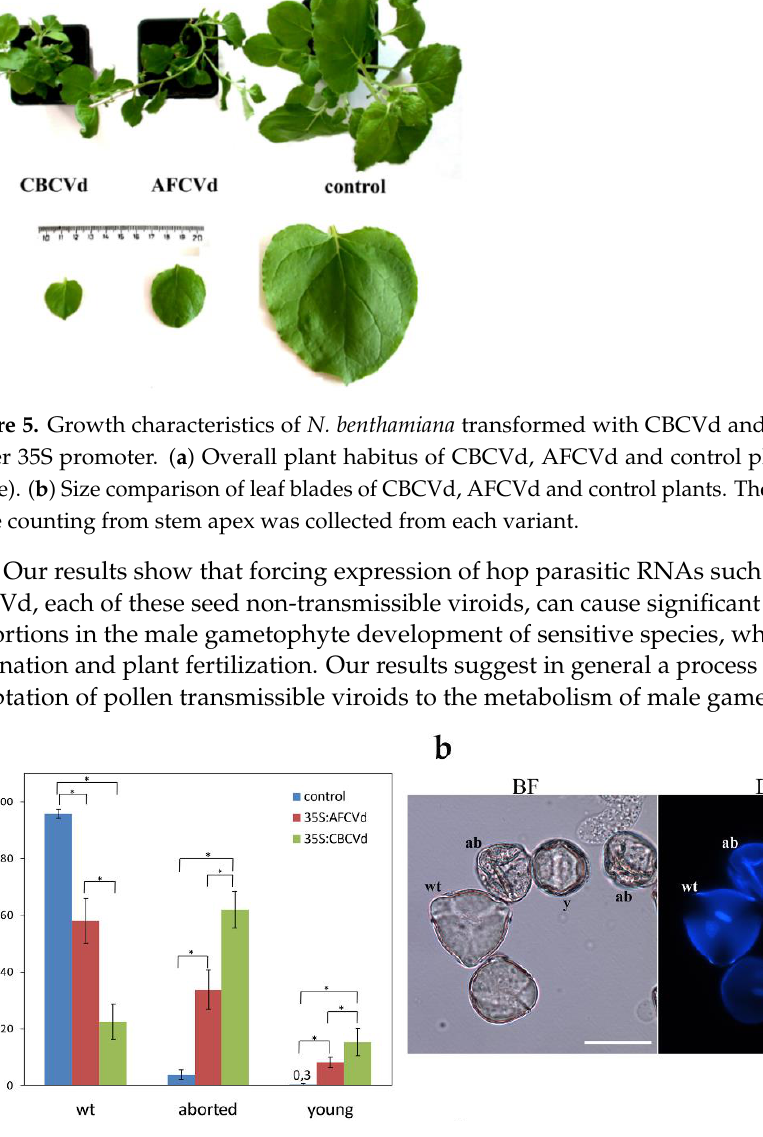
Figure 6. Microscopic analysis of mature pollen of control, 35S:AFCVd and 35S:CBCVd trans- formed N. benthamiana . ( a ) Quantification of the most common pollen phenotypes (in percent, mean ± S.D., n ≥ 9); healthy looking mature pollen grains (wt), aborted pollen (aborted) and young im- mature pollen grains (young). Lines with asterisks (* p < 0.05) indicate statistically significant dif- ferences between connected values. ( b ) Microscopic images of wt, aborted (ab) and young (y) pol- len grains quantified in graph. ( c ) Overall microscopic views of mature pollen of the relevant var- iant. ( d ) Microscopic images of trinuclear pollen grain (asterisk), pollen with malformed nucleus (m) and pollen with partially degraded nucleus (dn) found in mature pollen of 35S:CBCVd trans- formed plants. (BF) bright field, (DAPI) fluorescence after DAPI staining and scale 30 µm in all microscopic images. For plant transformation, the same plant vectors with dimeric AFCVd and CBCVd cDNAs under 35S promoter were used (Figure S5a,b [7]). N. benthamiana transformation was performed using the standard leaf disc method [40]. Regenerated transformed plants, designed as 35S:AFCVd and 35S:CBCVd, were maintained in a medium contain- ing 100 mg/L kanamycin and 200 mg/L Timentin. CBCVd infected hop pollen was collected in the middle of July 2017 from naturally infected male hop genotype 19058 grown in the experimental field of Slovenian Institute of Hop Research and Brewing. For AFCVd infection, male genotype from the crossing of female no. 211/96 x male no. 395/34 was obtained within the breeding and selection pro- gram in the Slovenian Institute of Hop Research and Brewing. Hop plants growing in the pots were AFCVd inoculated when having about 10 cm in height and forming up to three shoots using the biolistic method [26]. Each hop plant was inoculated five times in total